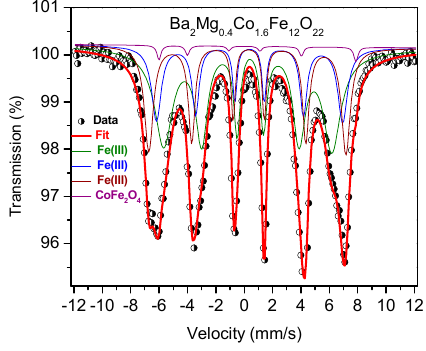
Figure 2. The Mössbauer spectrum of Ba 2 Mg 0.4 Co 1.6 Fe 12 O 22 material recorded at room temperature. The black dots and red solid lines refer to the experimental data and to the fit of the spectrum, respectively. Table 1. Hyperfine parameters 1 of the room-temperature Mössbauer spectrum of Iron Sites